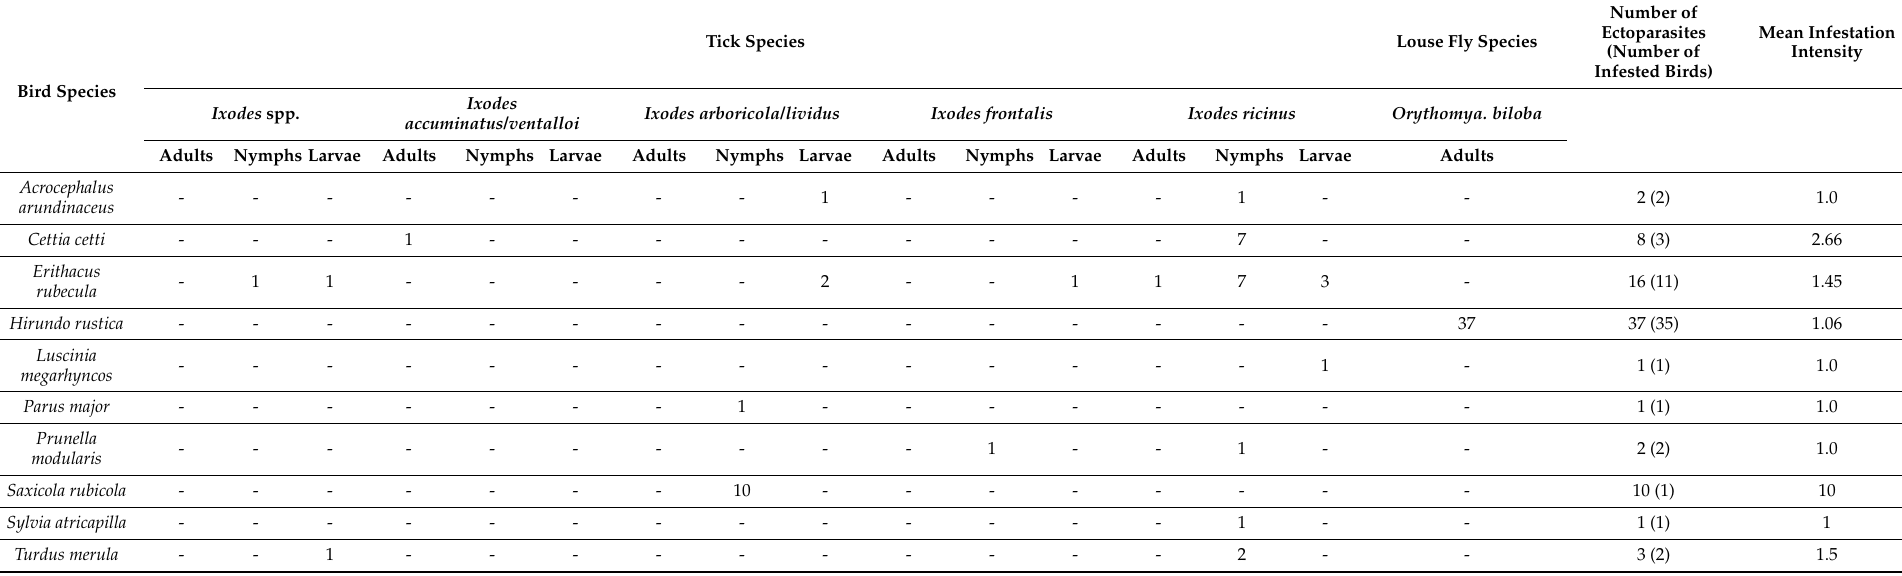
Table 4. Ectoparasites (ticks and louse flies) infesting passerine